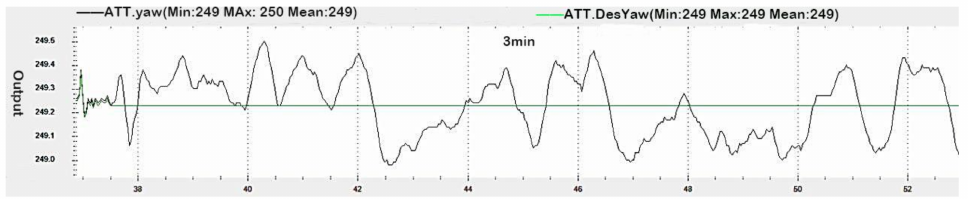
Figure 6. The curve of course angle of UAV under test condition 2. The curve in the graph is the sampling point curve, where the unit of the vertical axis is degree. The green line is the expected value of the heading angle, and the red line is the heading angle calculated by the dual antenna. The amplitude of the course is 0.5 degrees.